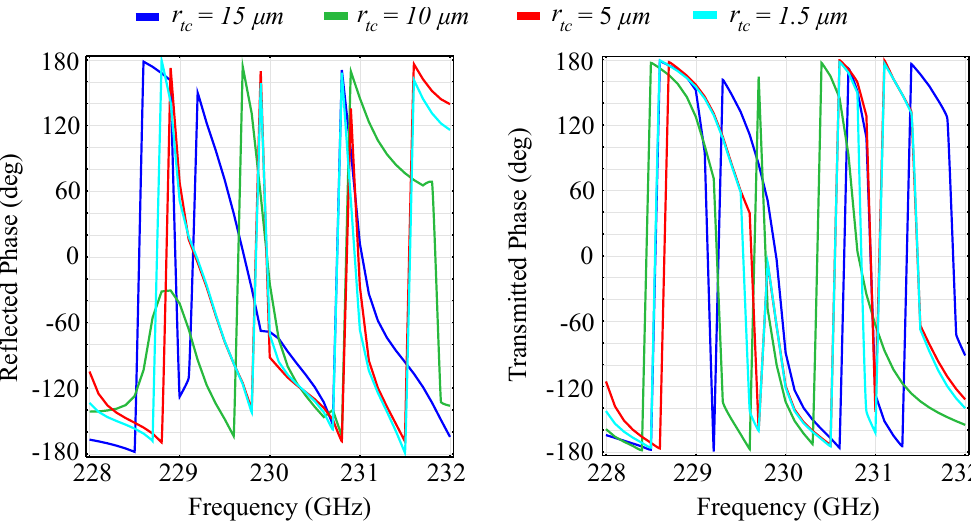
Figure 3. Simulated phase for the reflected and transmitted waves in the silica glass-based configuration, in which the top radius of the inner-ring cylinder r tc is varied between fixed values, in a transition from a cylinder to a